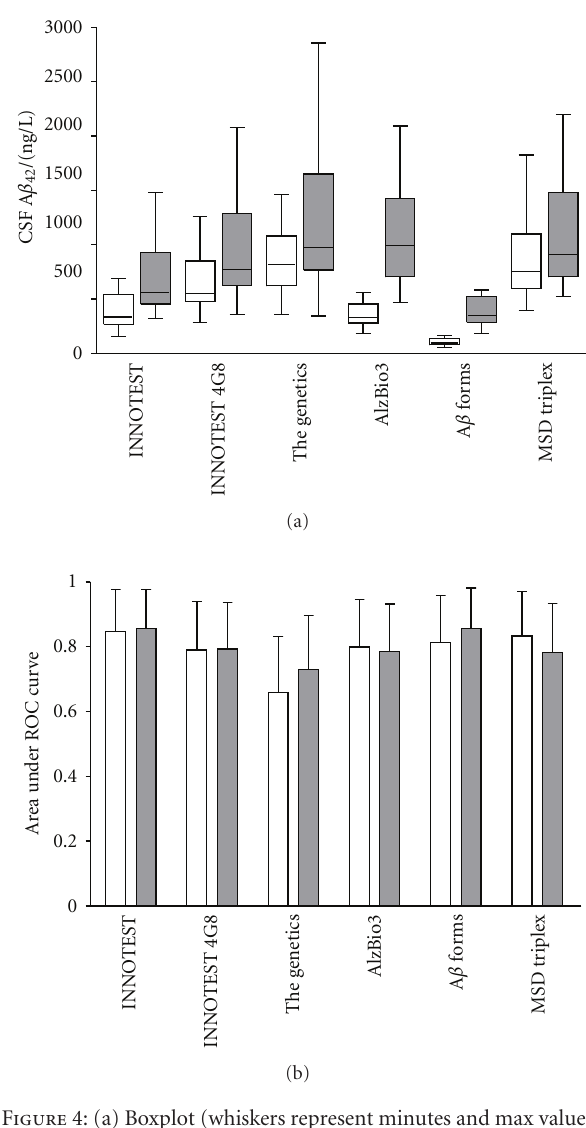
Figure 4: (a) Boxplot (whiskers represent minutes and max values) of CSF A β 42 concentrations using di ff erent assays. For each kit the CSF was analyzed twice, neat and threefold diluted in a detergent-containing bu ff er. Each box represents 40 samples (20 AD + 20 controls). (b) Area under ROC curve for di ff erent assays with whiskers representing a 95% confidence interval. Neat, and threefold diluted CSF are represented by white and dark boxes/bars,